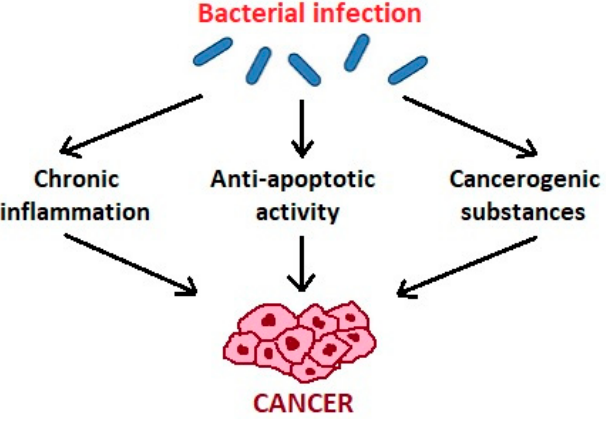
Figure 1. The influence of oral bacteria in the pathogenesis of cancer.